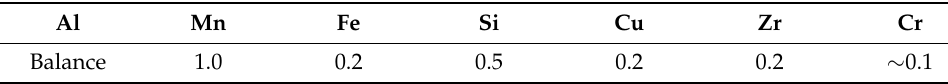
Table 1. Chemical composition of TRC AA 3003 alloy